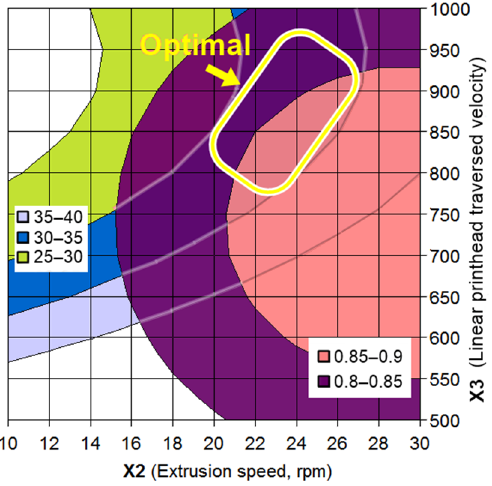
Figure 8. Effect of linear printhead traversed velocity and extrusion speed at the optimal layer thickness (0.8 of the nozzle diameter) on the layer thickness using the section coefficient.